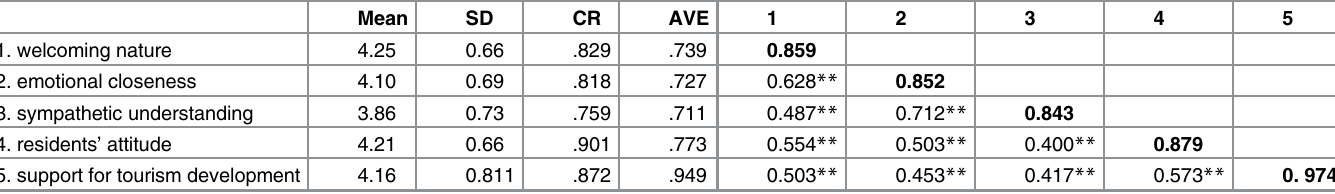
Table 1. Descriptive Statistics, Correlation, Composite Reliability and Average Variance Extracted.